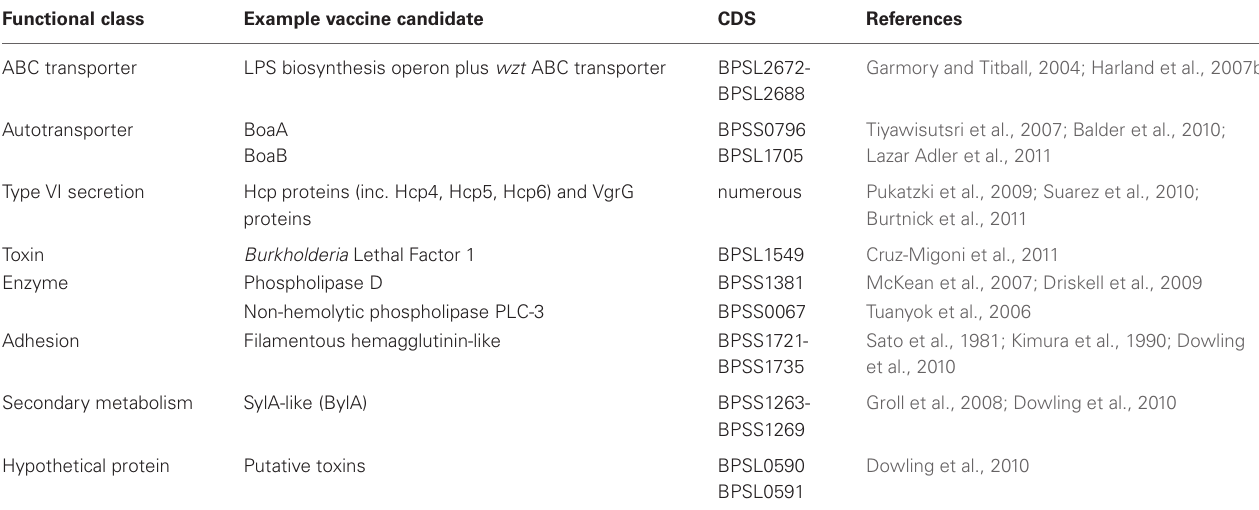
Table 1 | Examples of putative vaccine candidates